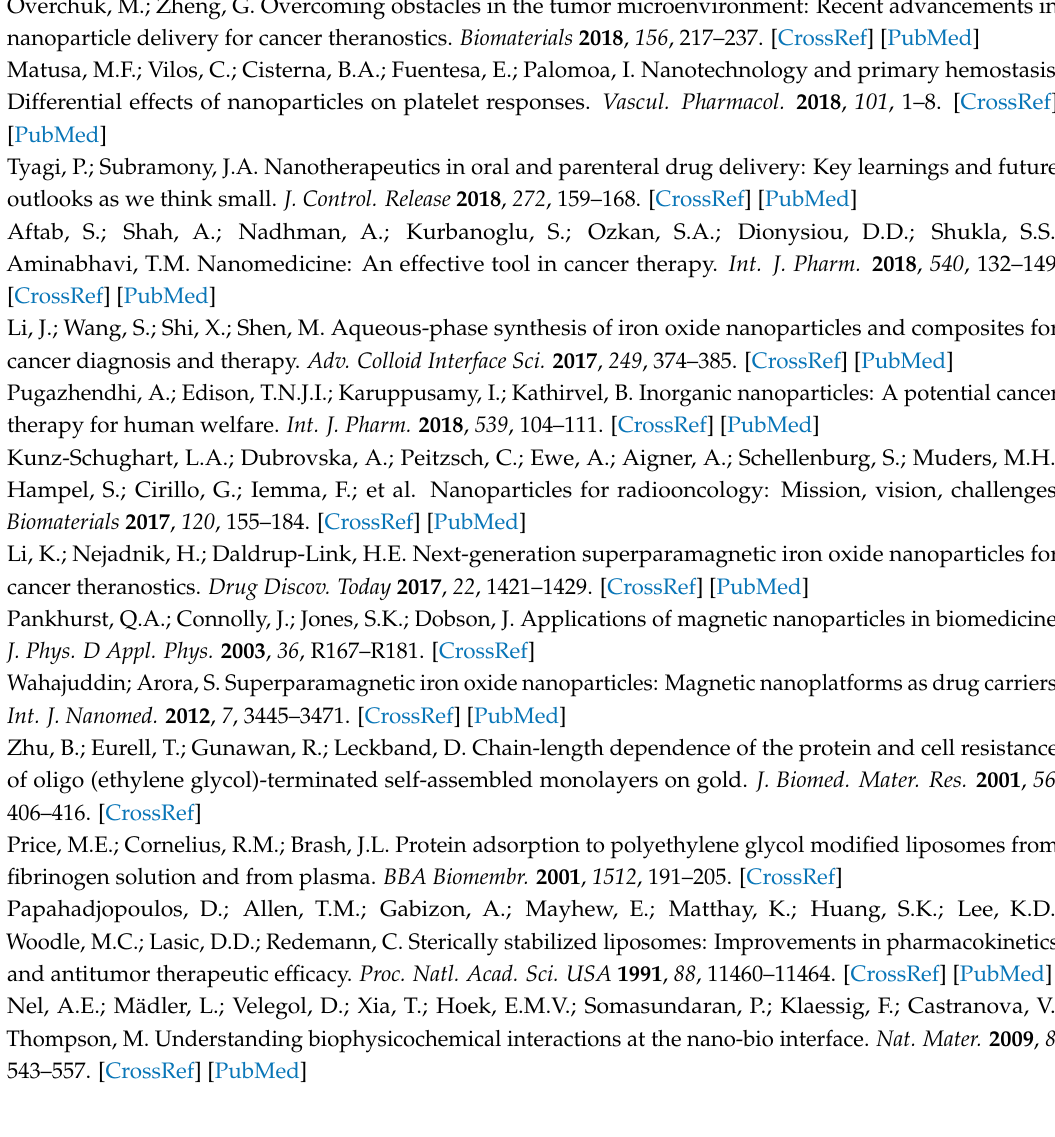
Figure S5: Evolution of protein corona on P(PEGMA-AA)@MNPs in human plasma in the total measured HP concentration range, as expressed through the changes in average hydrodynamic diameter ( Z ave ) measured in dynamic light scattering